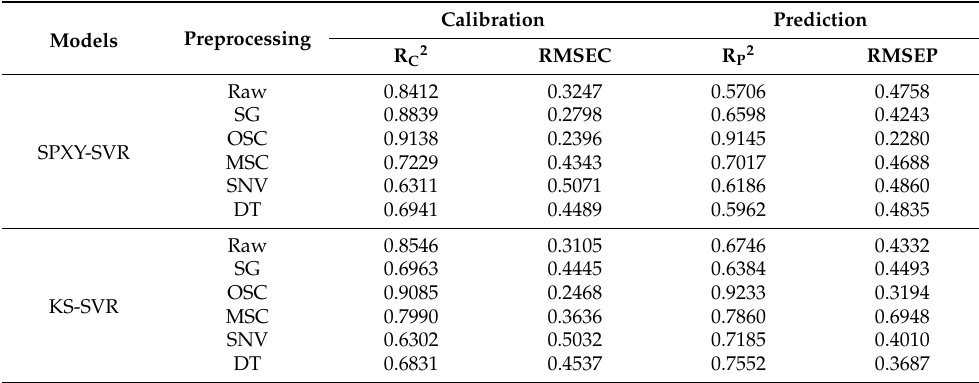
Table 2. Results of two diversity methods and five preprocessing